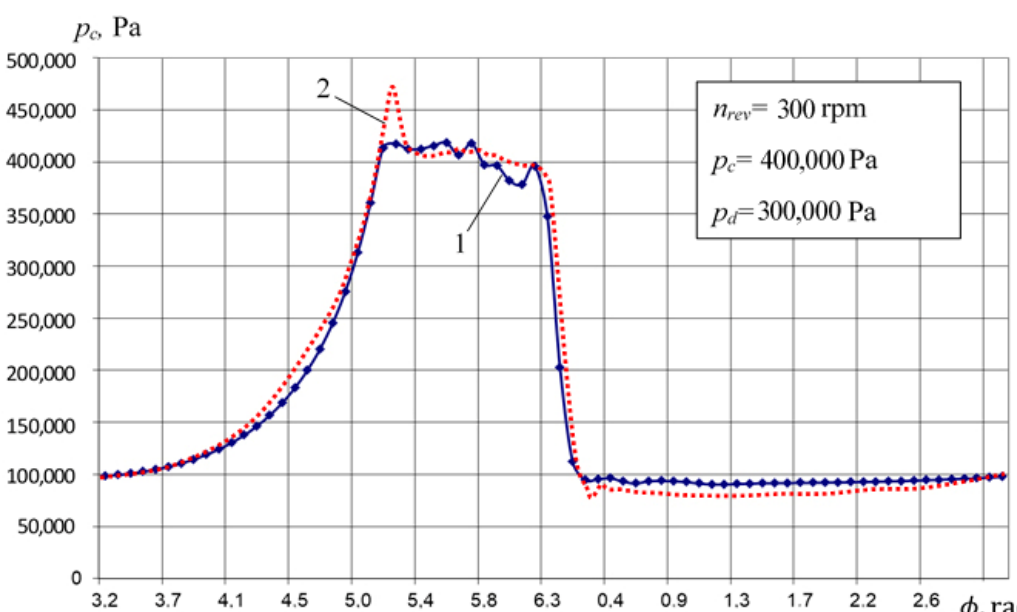
Figure 12. The dependence of the instantaneous pressure in the compressor section in crosshead-free PHPM determined experimentally and by calculation (1—Calculation; 2—Experiment).